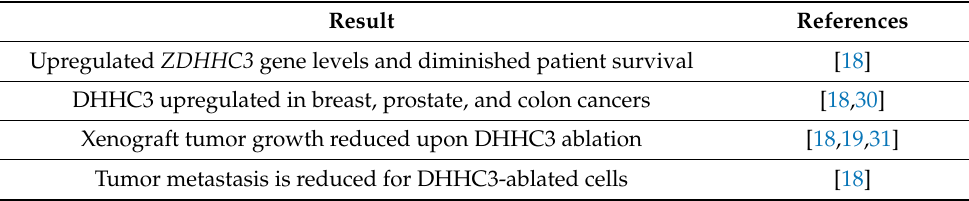
Table 2. DHHC3 plays a key role in